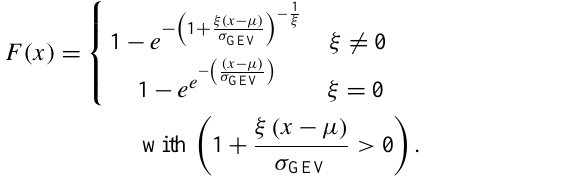
plot: This graph represents the theoreti- cal quantile against the observed quantile, i.e. (cid:26)(cid:18)